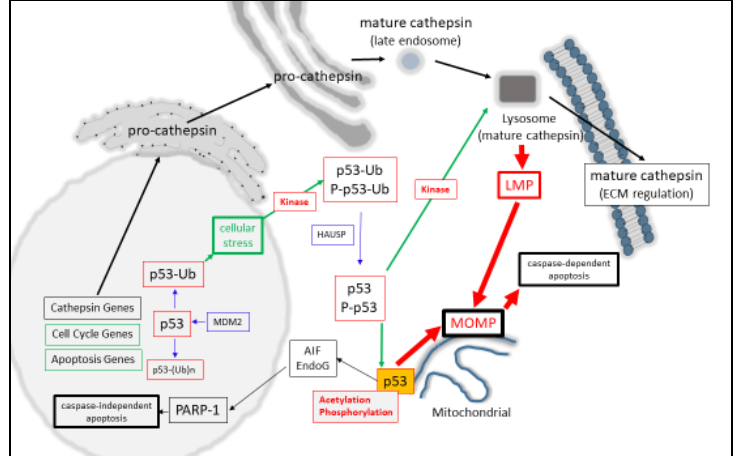
Figure 1. p53 regulates lysosomal- and mitochondrial-mediated apoptosis.